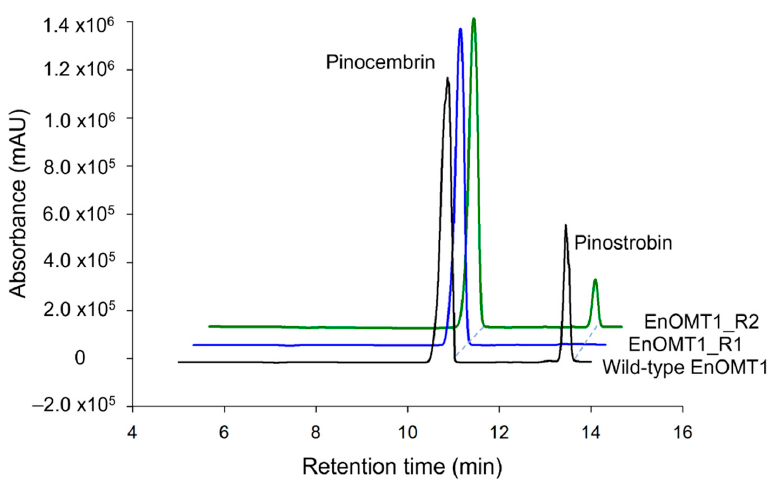
Figure 8. HPLC chromatograms of EnOMT1 mutant assay products. Each assay was incubated with 50 µ M pinocembrin as substrate for 10 min.